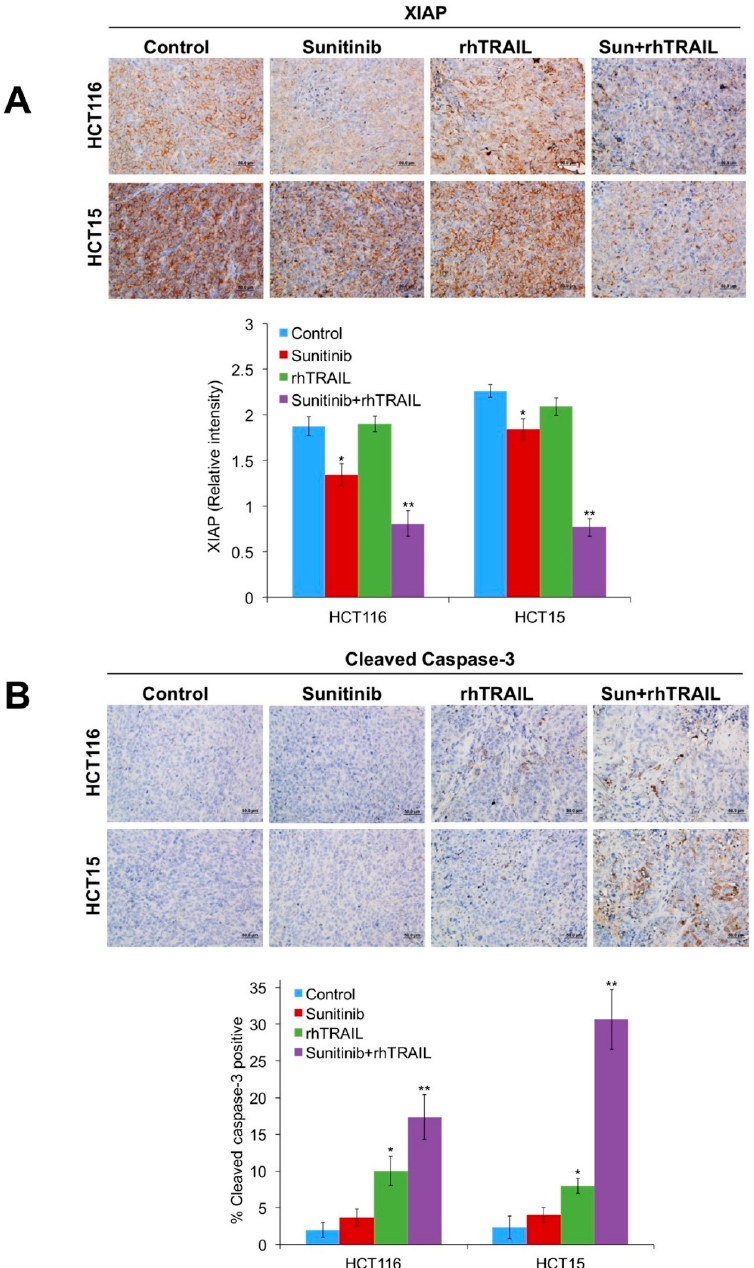
Figure 7. The combination of sunitinib and recombinant human tumor necrosis factor-related apoptosis-inducing ligand (rhTRAIL) significantly decreases X-linked inhibitor of apoptosis protein (XIAP) expression and increases cleaved caspase-3 levels. ( A – B ) Slides were stained with an (A) anti- XIAP or B) anti-cleaved caspase-3 antibody at 4 ° C overnight. Tumors were then incubated for 1 hour at room temperature with goat anti-rabbit horseradish peroxidase (HRP) antibody, followed by 3,3’- diaminobenzidine for 10 minutes. Slides were counterstained with hematoxylin. Quantification of expression levels of both XIAP and cleaved caspase-3-positive cells in tumor tissue is shown. Mean ± Standard Deviation (SD), n = 5. * Indicates a significant difference compared to vehicle control or ** compared to either single agent group, p <